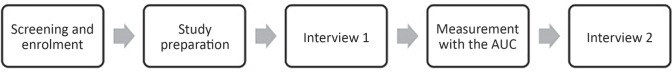
Flowchart of the study.